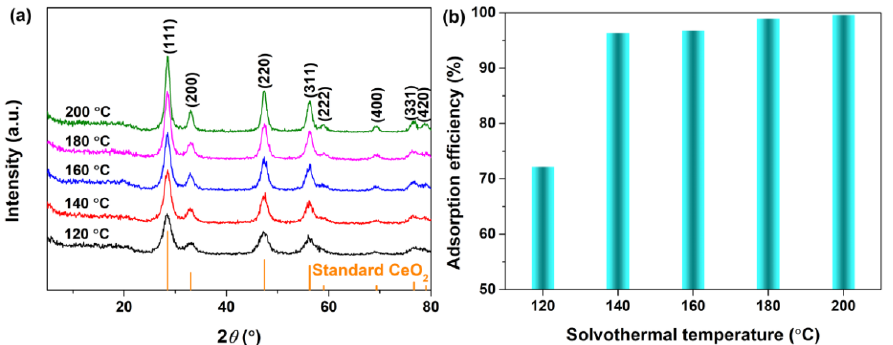
Figure 3. ( a ) XRD patterns of CeO 2 synthesized at a set hydrothermal temperature of 120~200 °C for 24 h with 4 mmol guanidine carbonate and 5 mL 30% H 2 O 2 . ( b ) Adsorption histograms of AO7 dye onto the as − obtained corresponding CeO 2 in Figure 3a ([CeO 2 ] = 2.0 g/L; [AO7] = 100 mg/L; V = 100 mL; 200 rpm; Room temperature; No pH preadjustment; t = 60 min).